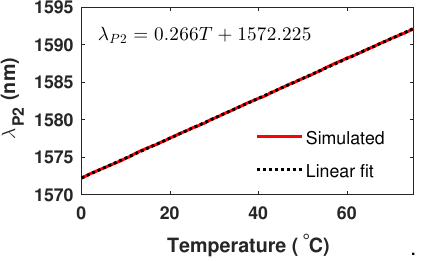
Figure 8. ( a ) Peak to peak amplitude of the IMF1 and ( b ) peak position of the IMF2 as a function of n 4 and T .